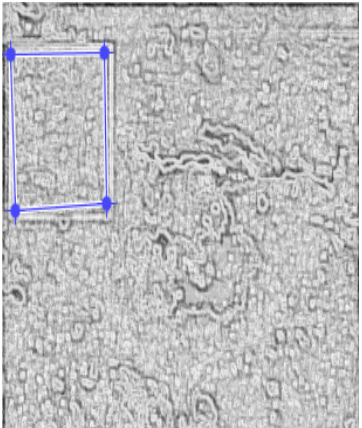
Figure 19. Applying the mask for lacunarity calculation.